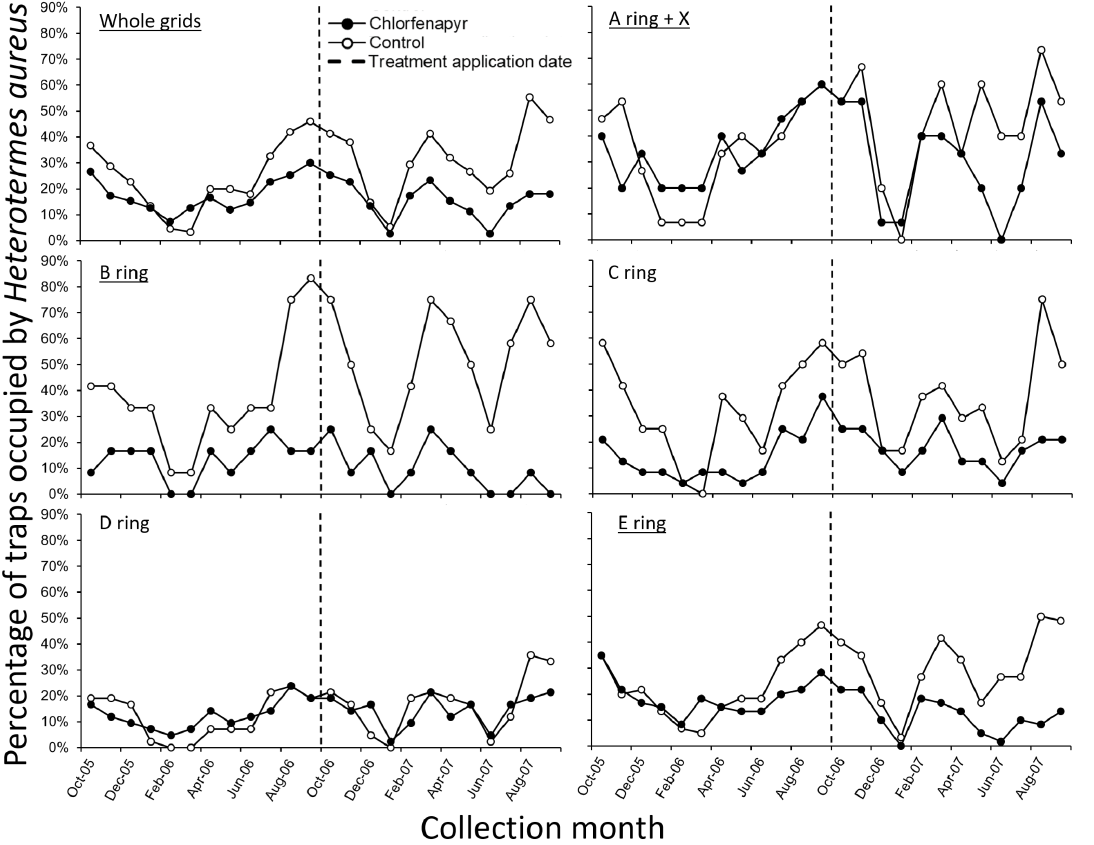
Fig 5 . Average percentage of termite stations occupied by H. aureus per month in whole control and chlorfenapyr experimental grids and each of their sections (n = 3 for each treatment). Labels for every other collection month are included in the horizontal axes. The names of grid sections for which analysis showed a significant change in the percentage of stations occupied by H. aureus with respect to controls after treatment application are shown